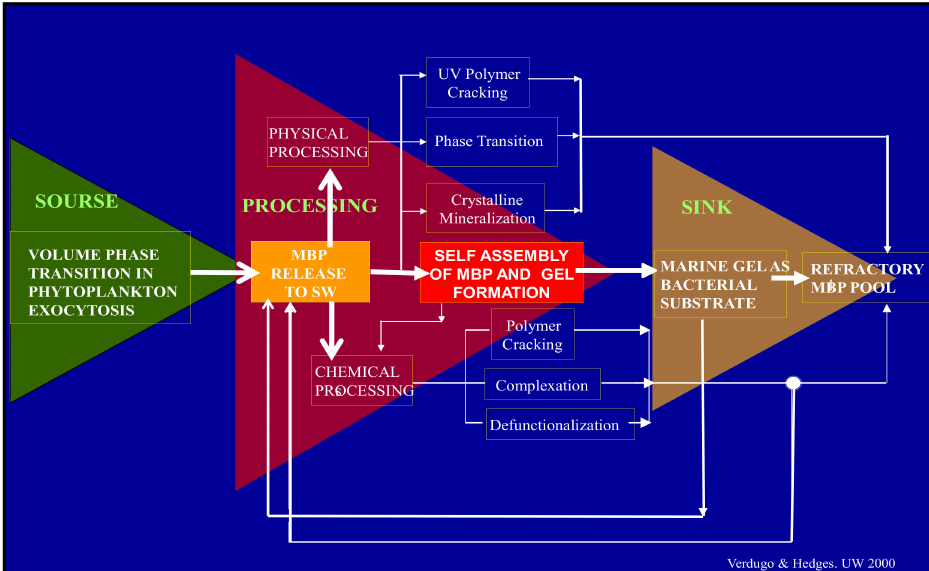
Figure 1. Before their release to SW, MBP are held inside phytoplankton secretory granules. They are gels stored in a condensed phase inside the cell. Upon export from the cell by exocytosis they undergo typical polymer gel phase transition to solvated phase with massive swelling. They are finally released as loosely woven physical hydrogels. Once discharged to SW, MBP can separate, disperse broadly to join the dissolved organic matter (DOM) pool. While in the DOM pool, MBP can undergo multiple physical or chemical processes. Among those, self-assembly is the one that results in the formation of MGs. Marine gels contain 10 4 more organic material than their MBP dissolved precursors. MG form discrete patches of concentrated substrate that bacterial enzymes can readily cleave [4]. While cleaved residues <600 D can be readily incorporated and metabolized by marine bacteria (MB) and thereby enter the food chain to higher trophic levels, larger cleaved residues can reenter self-assembly. However, enzymatic cleavage also leaves behind a stock of residues too large to be incorporated and metabolized by bacteria but too small to self-assemble. These leftovers from bacterial enzyme cleavage are likely to join the refractory organic stock found in the ocean. Implicit in this model is the hypothesis that MG is necessary and perhaps sufficient to drive the global flux of carbon up the food web with ramifications that scale to global cycles of marine bioactive